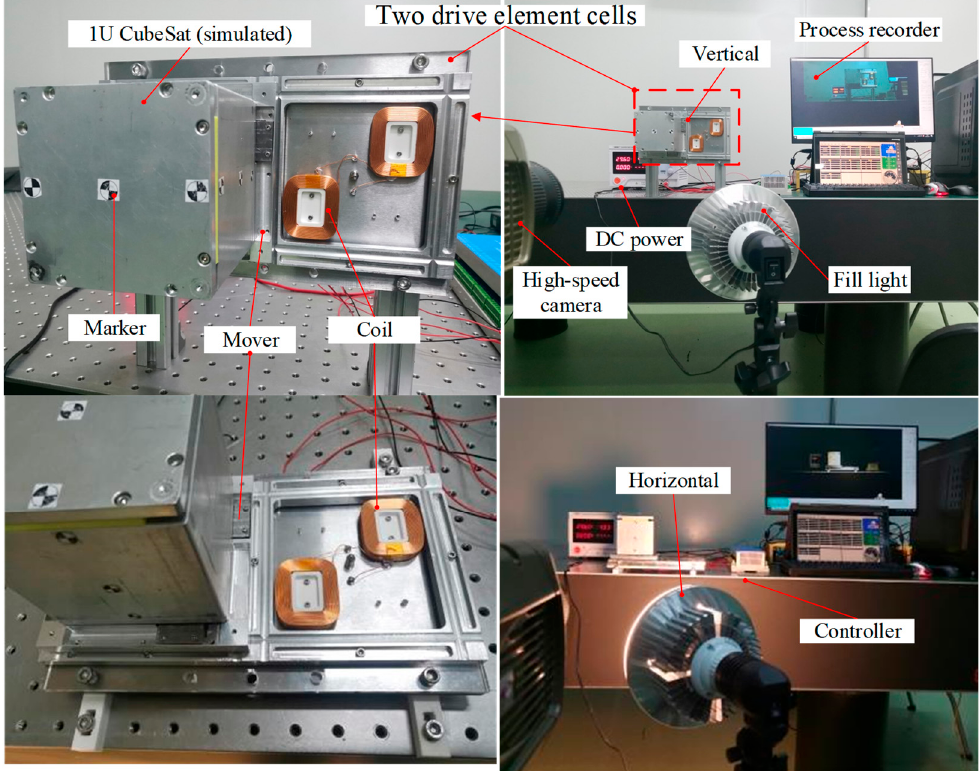
Figure 21. Measurement of motion process.